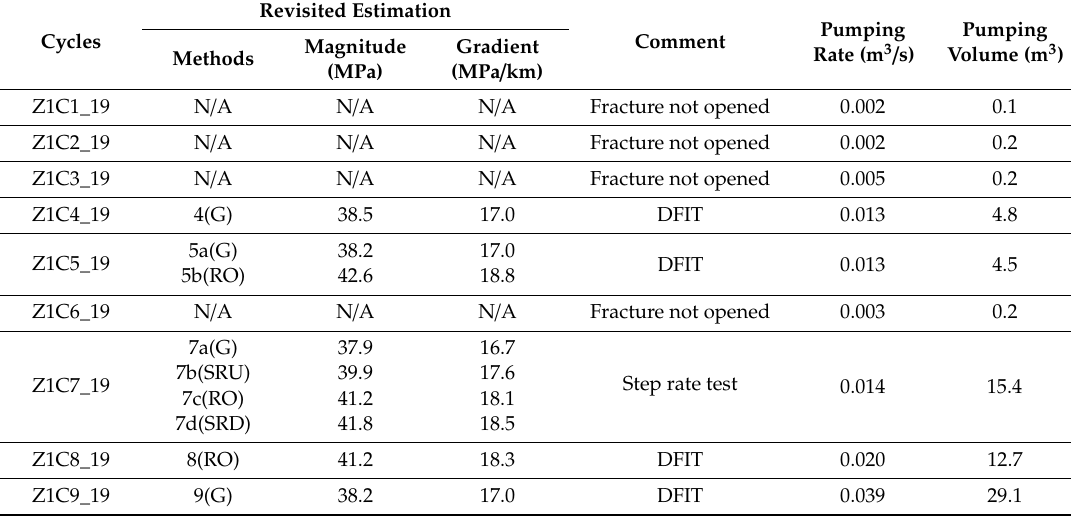
Table A2. Closure pressure measurements of Zone 1, 2019 (TVD 2262